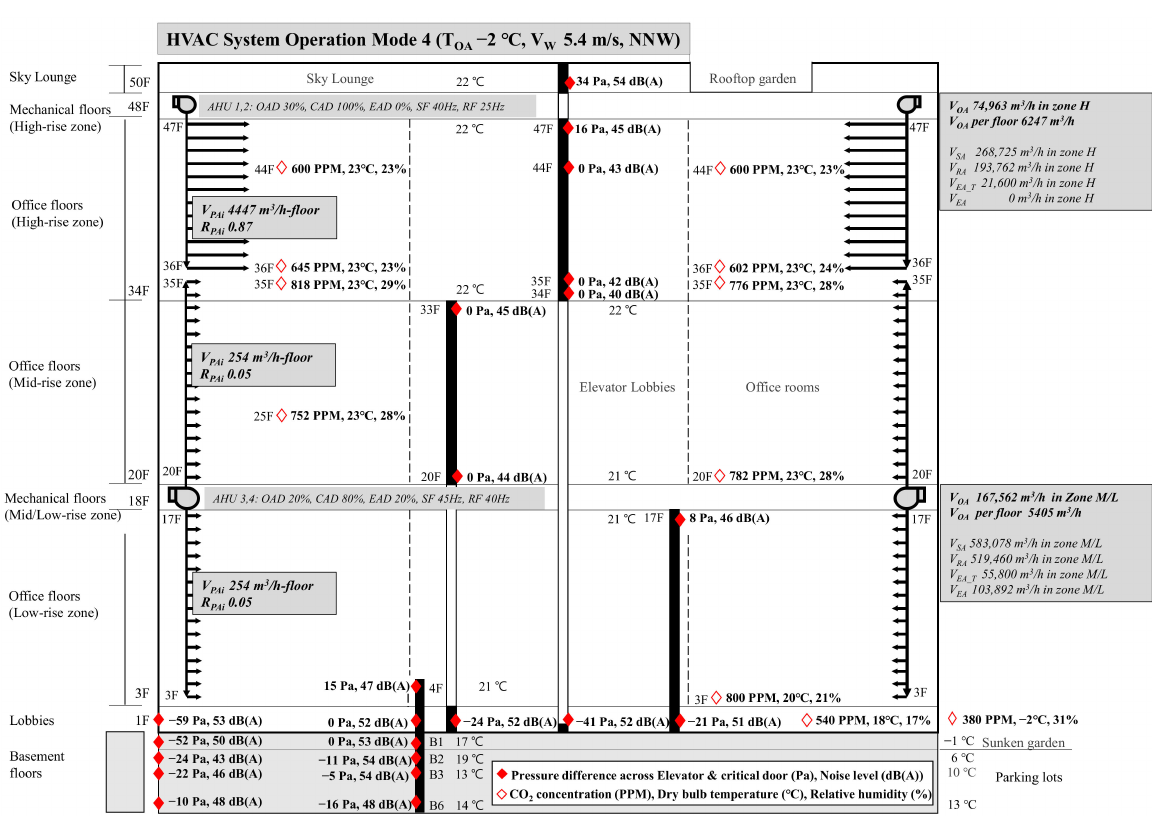
Figure 12. Distribution of indoor air environment in HVAC pressurization of high-rise zone (Operation Mode